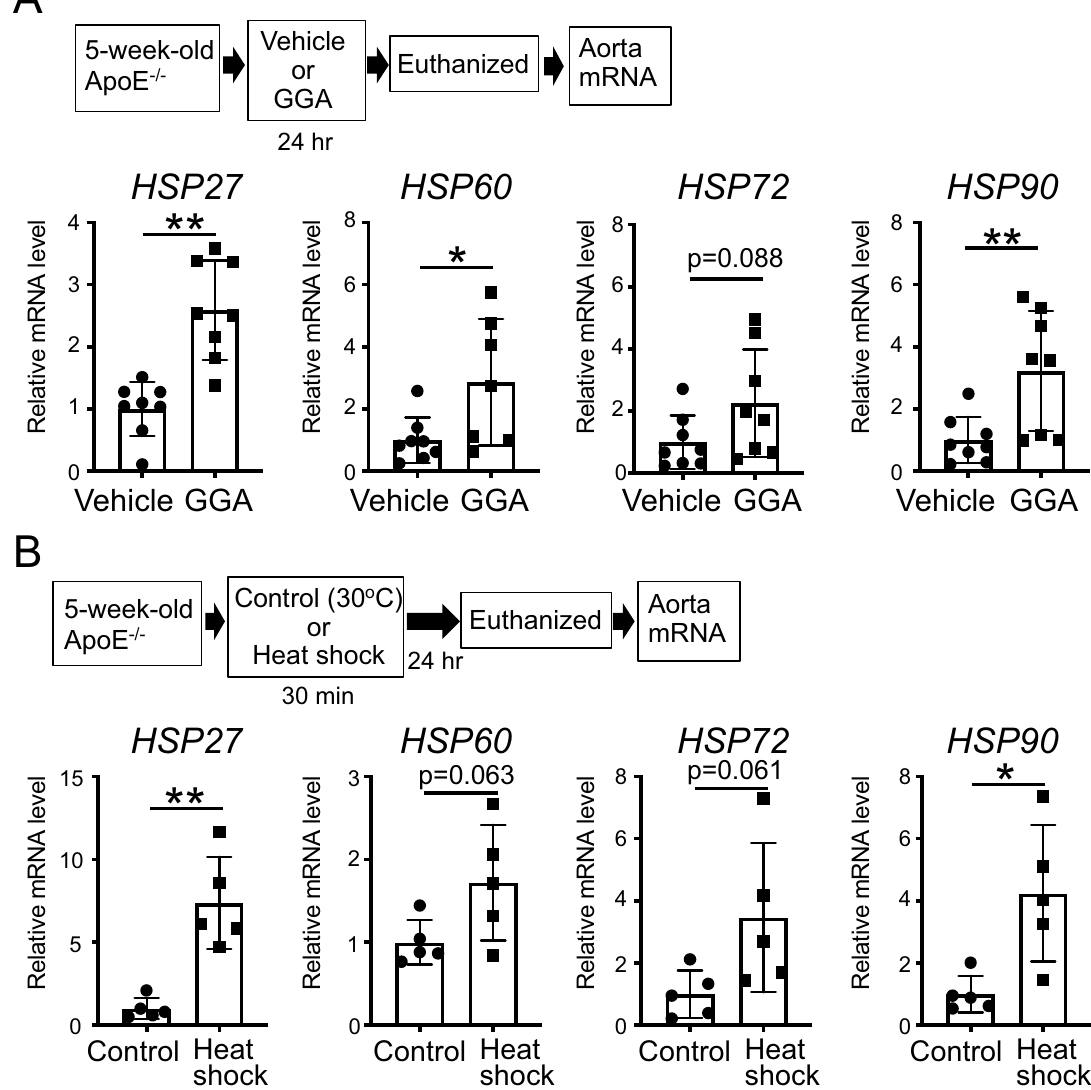
Figure 2. Effect of the induction of heat shock proteins (HSPs) in mice treated with geranylgeranylacetone (GGA) or subjected to heat shock. ( A ) HSP27 , 60 , 72 , and 90 mRNA expression levels in the aorta after GGA administration. 5-week-old ApoE −/− mice were administered vehicle or GGA (500 mg/kg/day) for 24 h, and total RNA was subsequently extracted from the aorta. ( B ) HSP27 , 60 , 72 , and 90 mRNA expression levels in the aorta after heat shock treatment. 5-week-old ApoE −/− mice were exposed to a 30 °C (control) or 41 °C (heat shock) bath for 30 min. After 24 h, total RNA was extracted from the aorta. Each bar represents the mean ± standard deviation (SD). Significant differences are marked on the chart (*p < 0.05; **p < 0.01). n = 5–8 mice per